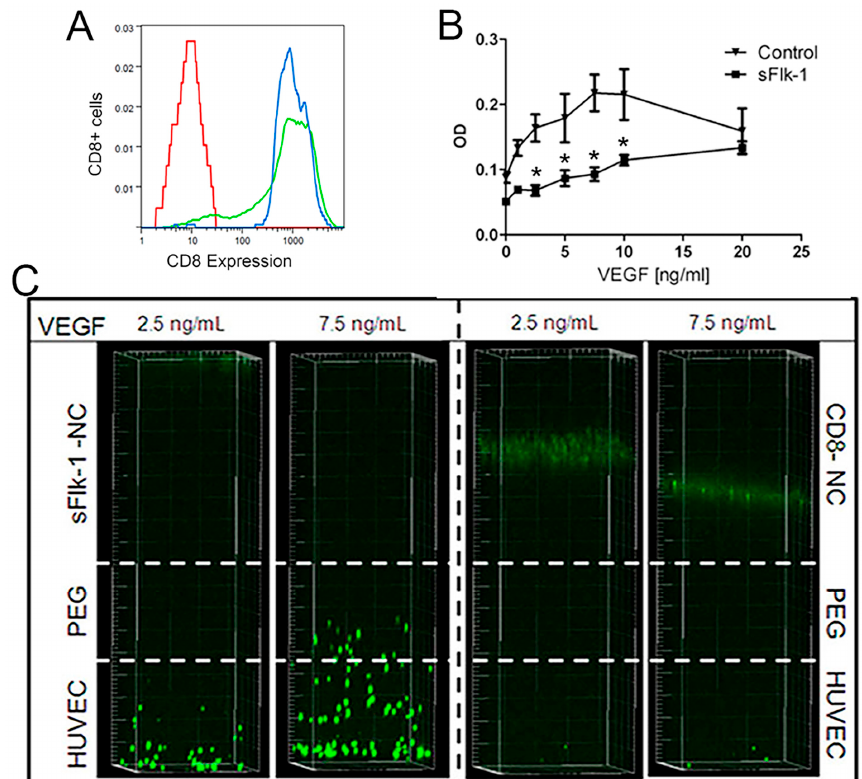
Figure 1. In vitro expression of CD8 and bio-activity of the sFlk-1 released by genetically modified human nasal chondrocytes. ( A ) Representative Fluorescence-activated cell sorting (FACS) plot shows that nasal chondrocytes (NC) had transduction efficiency above 80% (green-tinted plot) and populations of CD8-positive cells were purified after sorting (blue-tinted line). Not stained cells were acquired as control (in red). ( B ) Human umbilical vein endothelial cells (HUVEC) metabolic activity assay showing that sFlk-1-containing supernatants efficiently blocks Vascular Endothelial Growth Factor (VEGF). CD8-expressing NC supernatants were used as control (2 donors, n = 4). ( C ) HUVEC migration assay after 12 h showing that sFlk-1-expressing NC hampered HUVEC migration by blocking different gradients of VEGF, whereas CD8-only expressing NC allowed HUVEC migration. * p < 0.01.